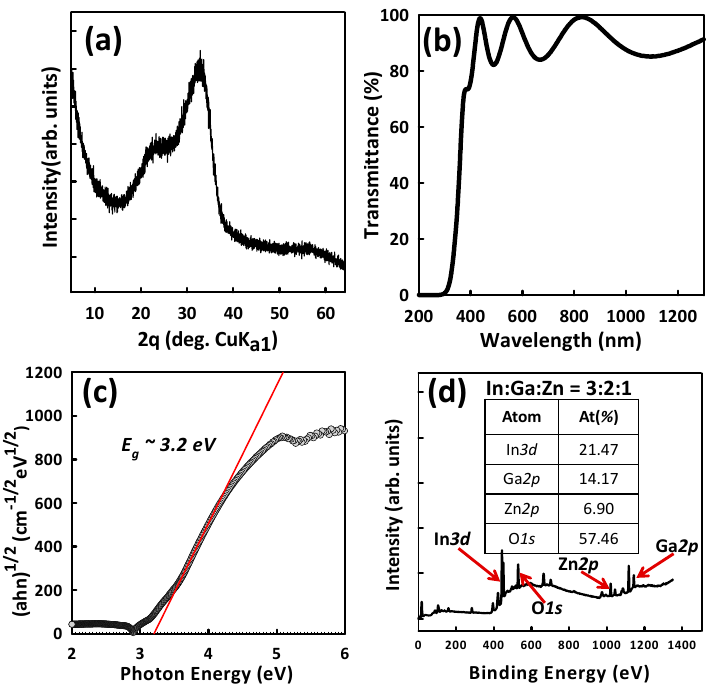
Figure 3. Material properties of amorphous indium-gallium zinc-oxide films. ( a ) X-ray diffraction patterns, ( b ) transmittance, ( c ) Tauc’s plot, and ( d ) X-ray photon electron spectroscopy.